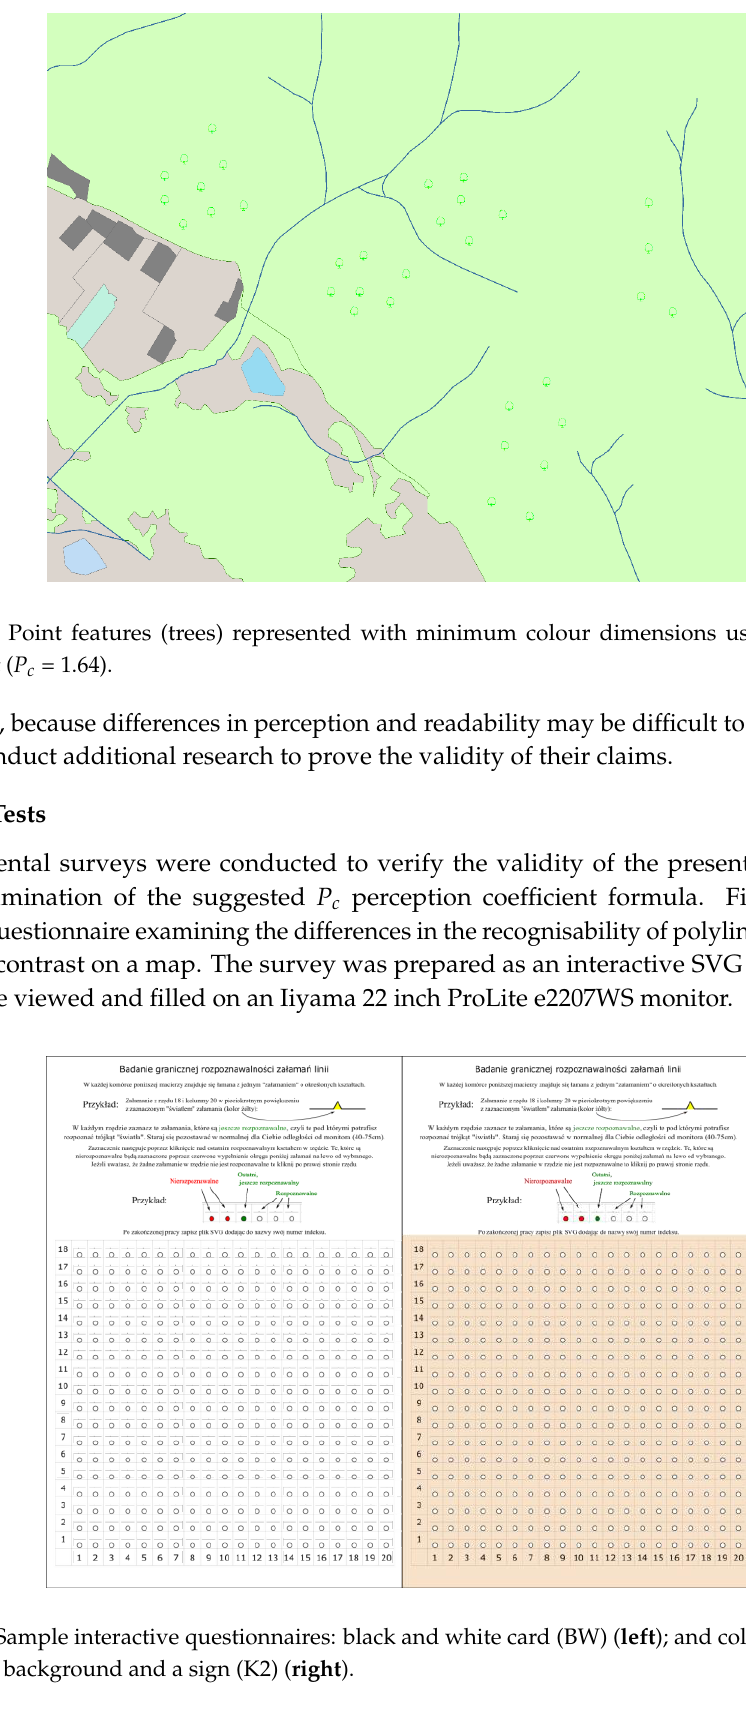
Figure 5. Sample interactive questionnaires: black and white card (BW) ( left ); and colour card with a chromatic background and a sign (K2) ( right ).